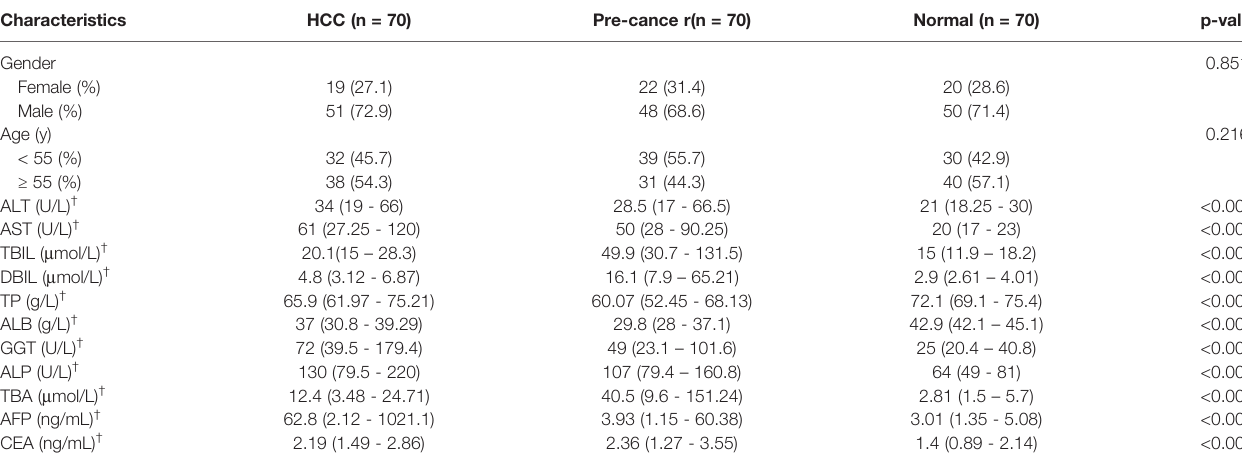
TABLE 1 | Clinical characteristics of patients in the study. Characteristics